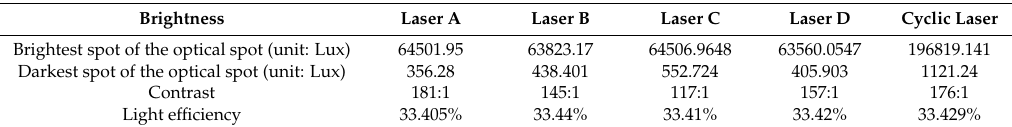
Table 6. Contrast and light efficiency for a single blue laser and cyclic micro-scanning laser (liquid crystal lens with pore size of 2.0 mm and a focal length of 9 cm). Brightness